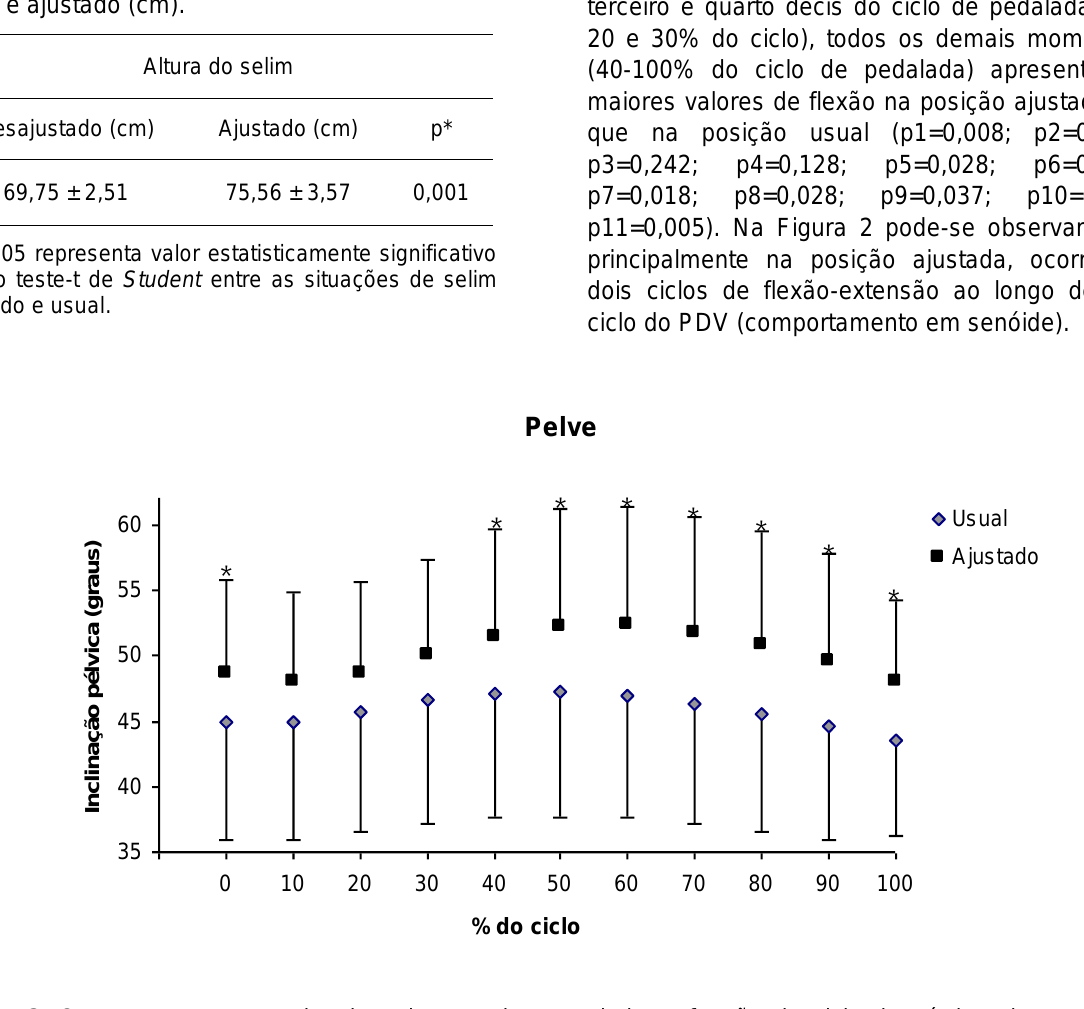
Figura 2. Comportamento angular da pelve no plano sagital em função do ciclo do pé-de-vela nas duas posições adotadas. * p<0,05 representa valor estatisticamente significativo ( Bonferroni ) entre as situações de selim ajustado e